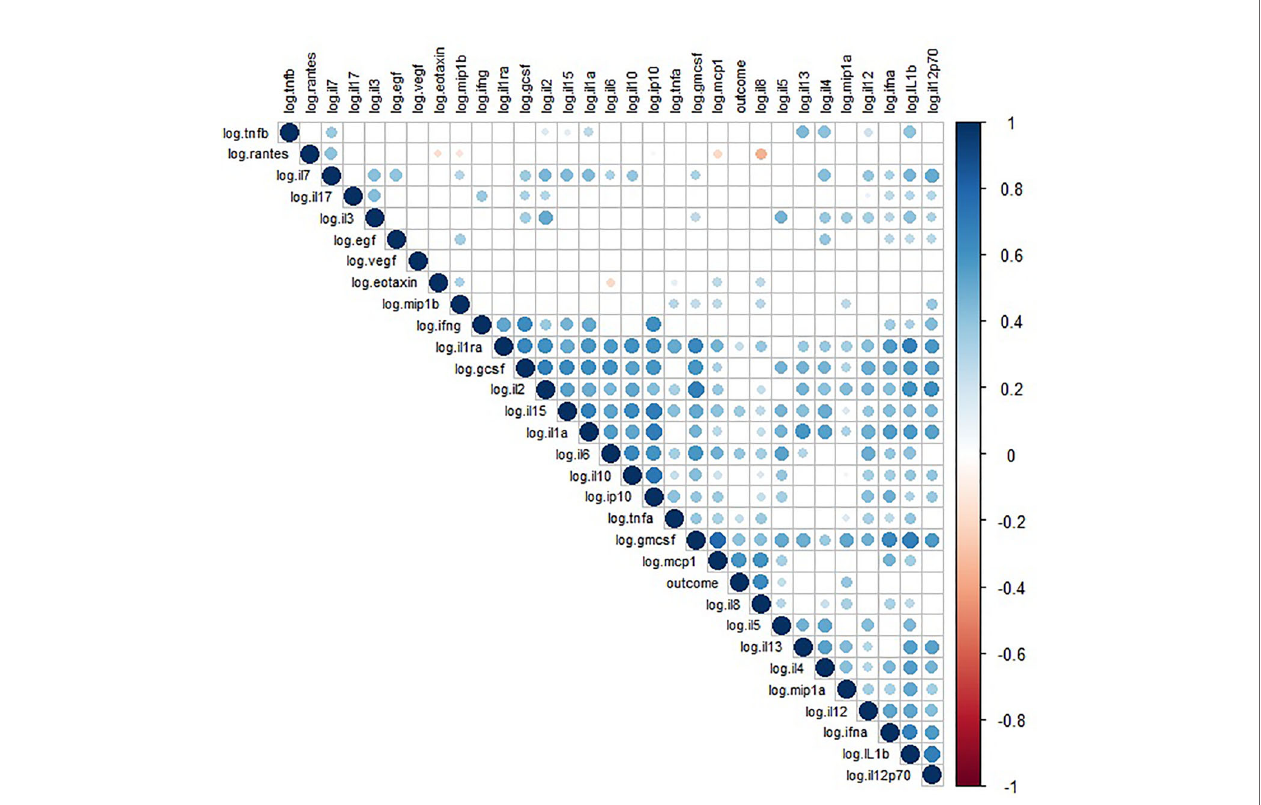
FIGURE 3 | Spearman correlation matrix between biomarkers concentrations. Only signi fi cant correlations are shown (p > 0.05). The outcome in this analysis is death.